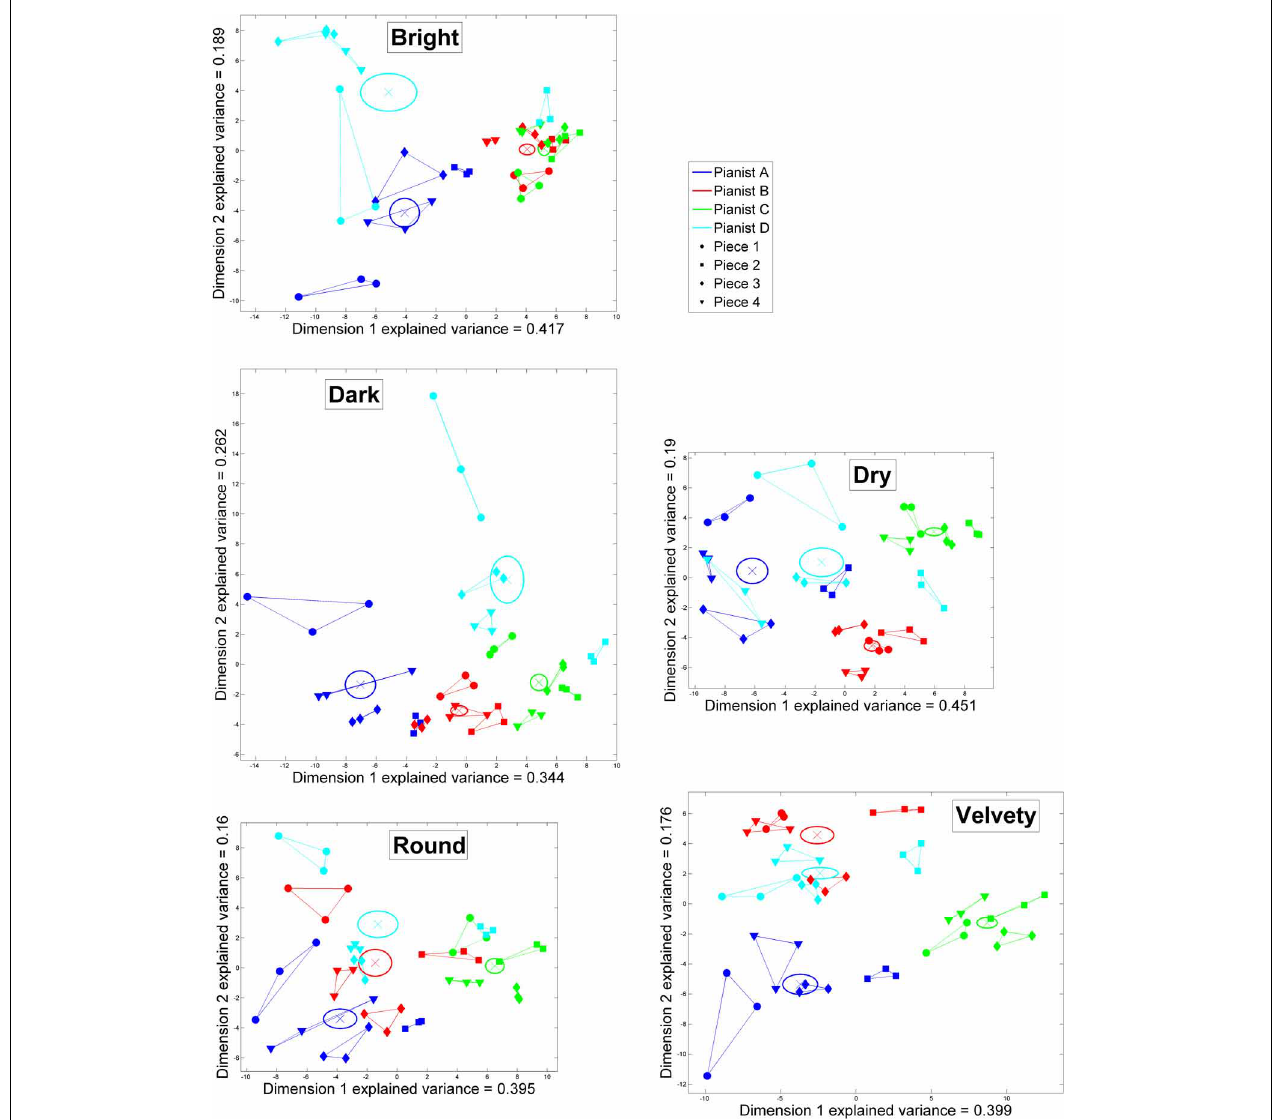
FIGURE 4 | Principal Component Analysis of the performance features highlighting pianists’ individuality over each set of 48 performances corresponding to a different timbral nuance (bright, dark, dry, round, or velvety): two-dimensional reduced